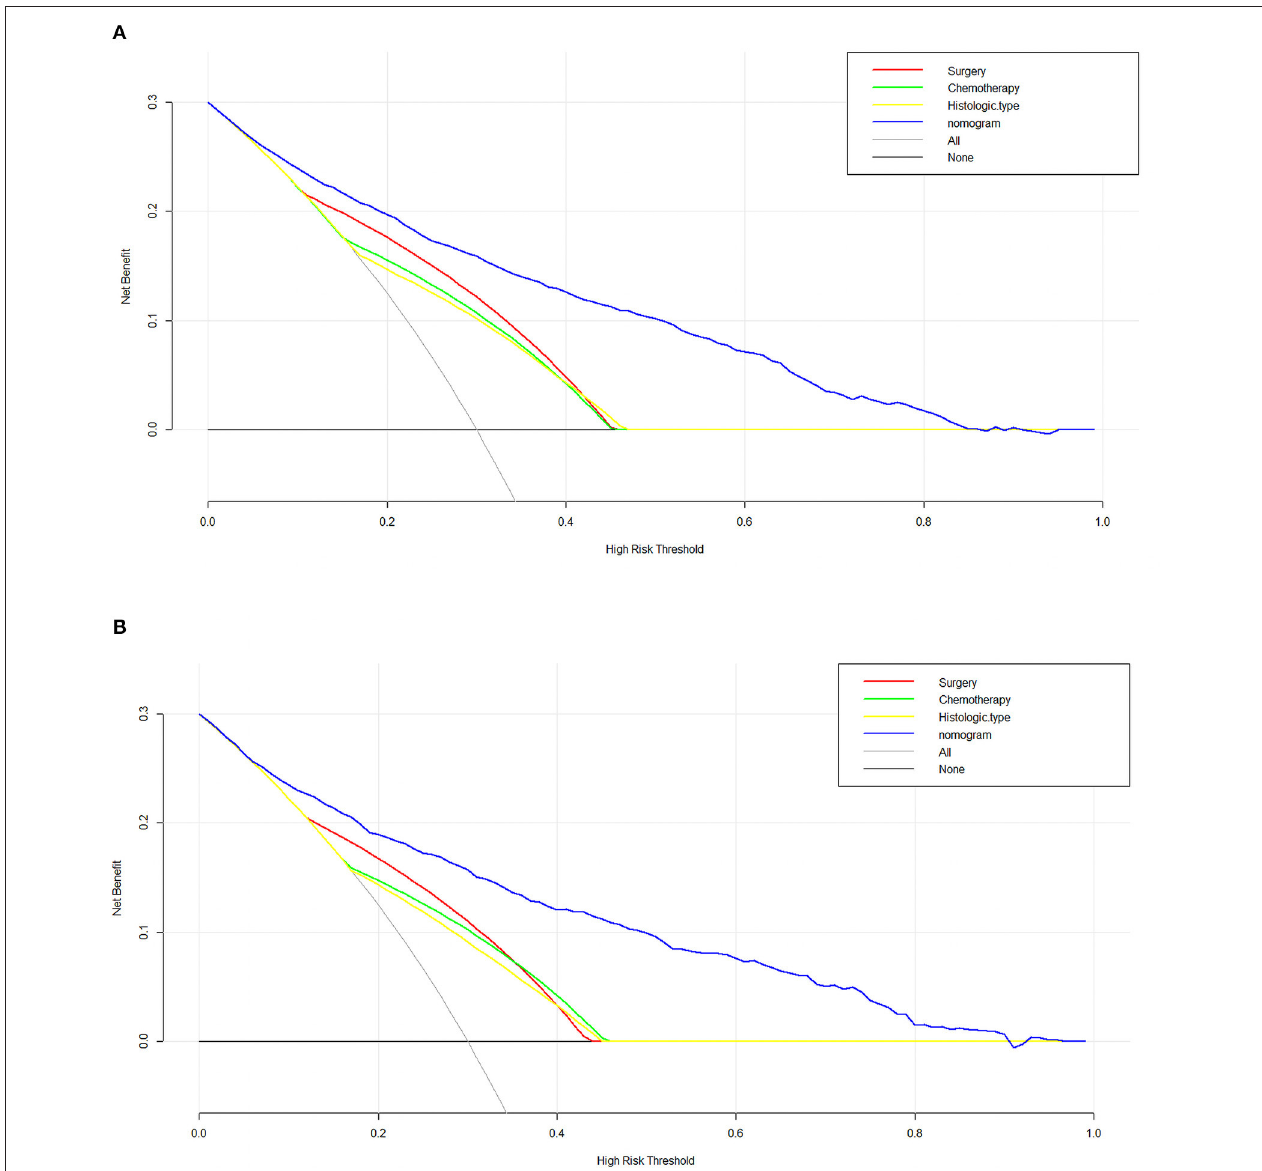
FIGURE 5 | The decision curve analysis (DCA) curve for the nomogram in the training cohort (A) and the Validation cohort (B)